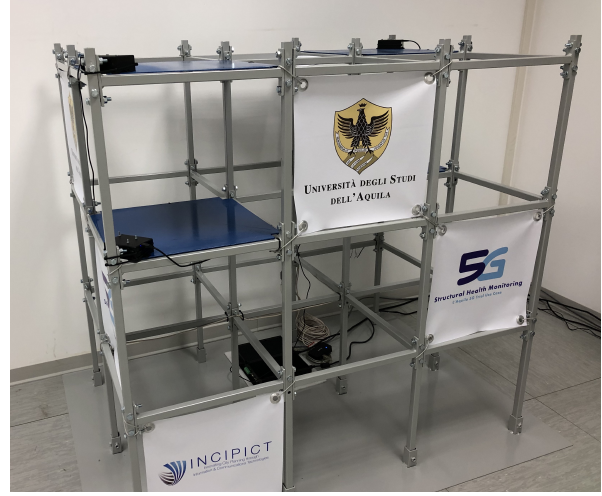
Figure 5. Test frame equipped with sensor boards and connected to a 5G CPE.